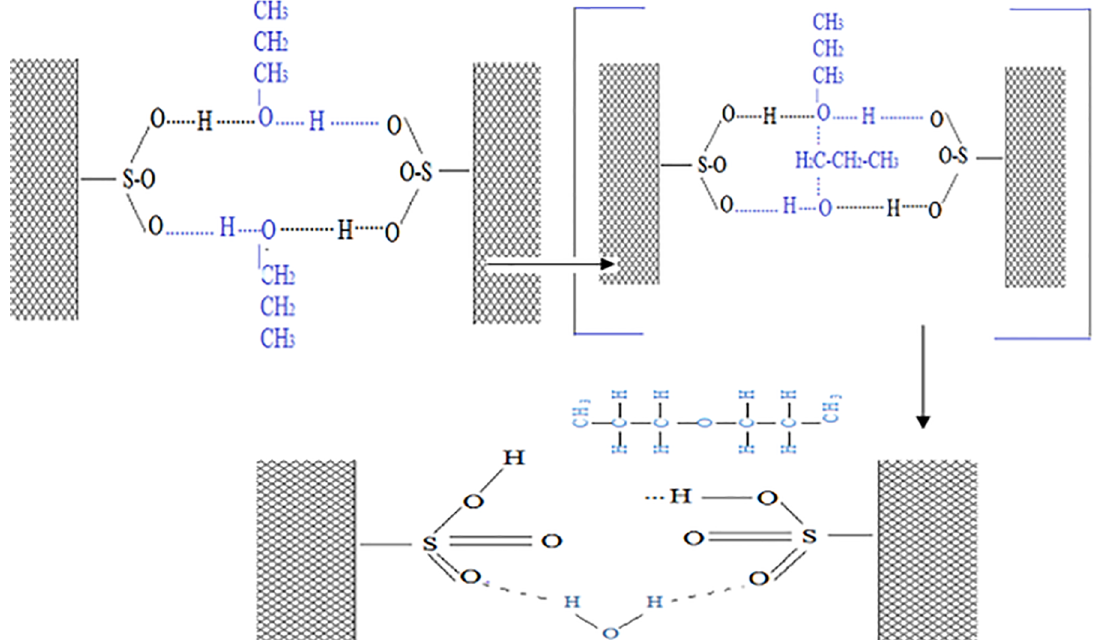
Figure 7. Suggested mechanism of 1-propanol dehydration catalyzed by acidic groups –SO